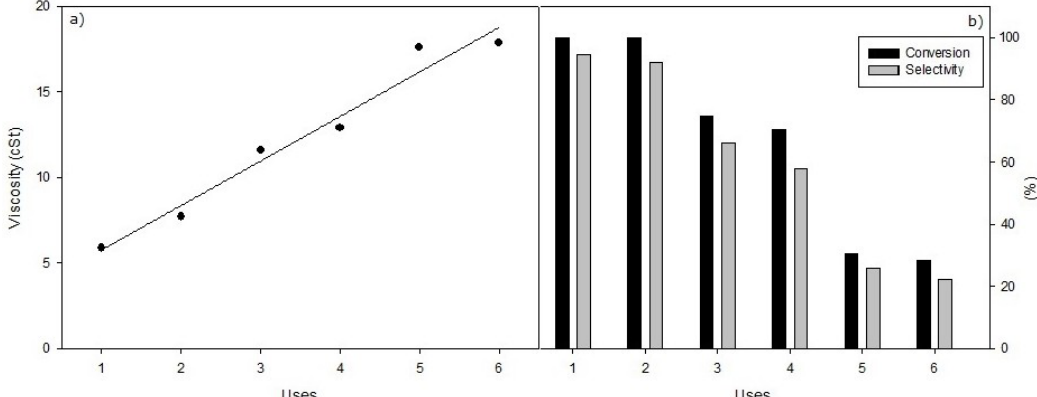
Figure 8. ( a ) Viscosity values obtained in the successive reuses of heterogeneous selective methanolysis of sunflower oil (viscosity 32.0 cSt) under standard conditions, with 0.8 g of KF/MgO, 65 °C, 12 mL of oil and 2.43 mL methanol. ( b ) Conversion and Selectivity values obtained with identical